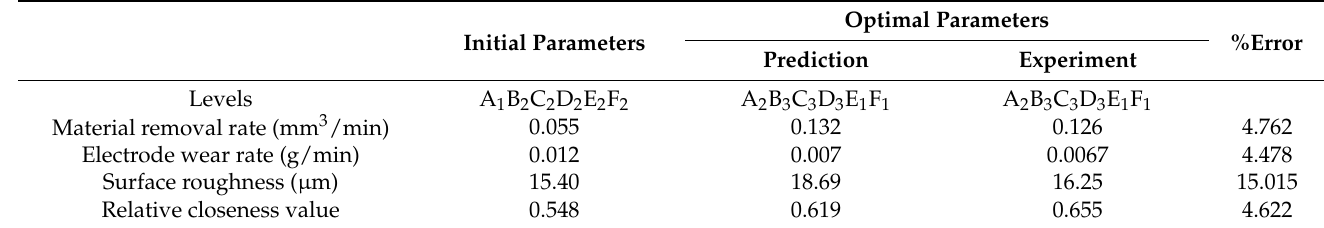
Table 15. Results of machining performance using the initial and optimal machining factors. Initial